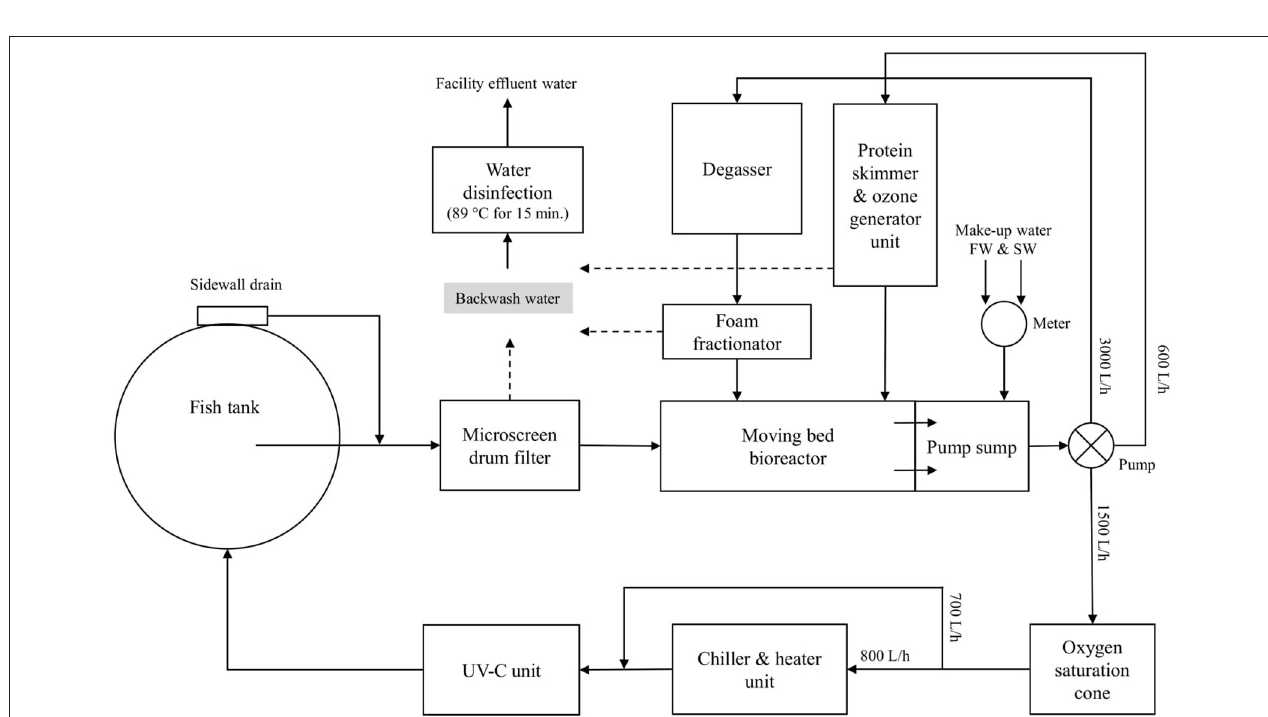
FIGURE 3 | Process flow scheme of the RAS units. Water flows are listed. The nine individual RAS units are located in one of the infection rooms of the research facility ( Figure 2 ). Each individual RAS contains a cylindroconical experimental tank (V = 0.5 m 3 ) with a dual outlet drain, an emergency oxygen stone, and a sensor for oxygen and temperature (Oxyguard R (cid:13) , Farum, Denmark). The water flow scheme across the different RAS units is shown in Figure 3 . Briefly, the water flows out